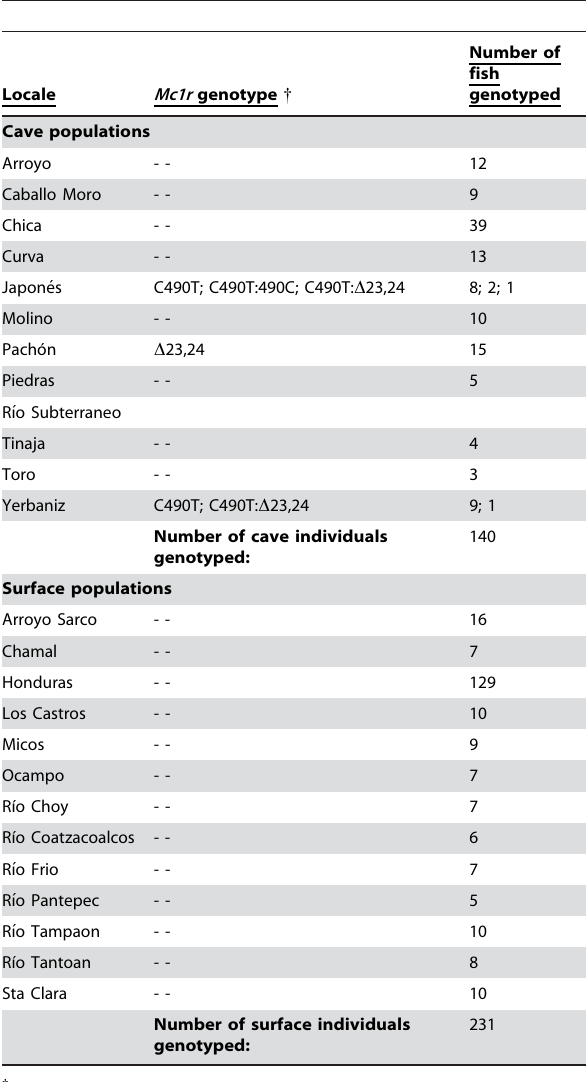
Table 1. Summary of variant Mc1r genotypes collected from multiple cave and surface